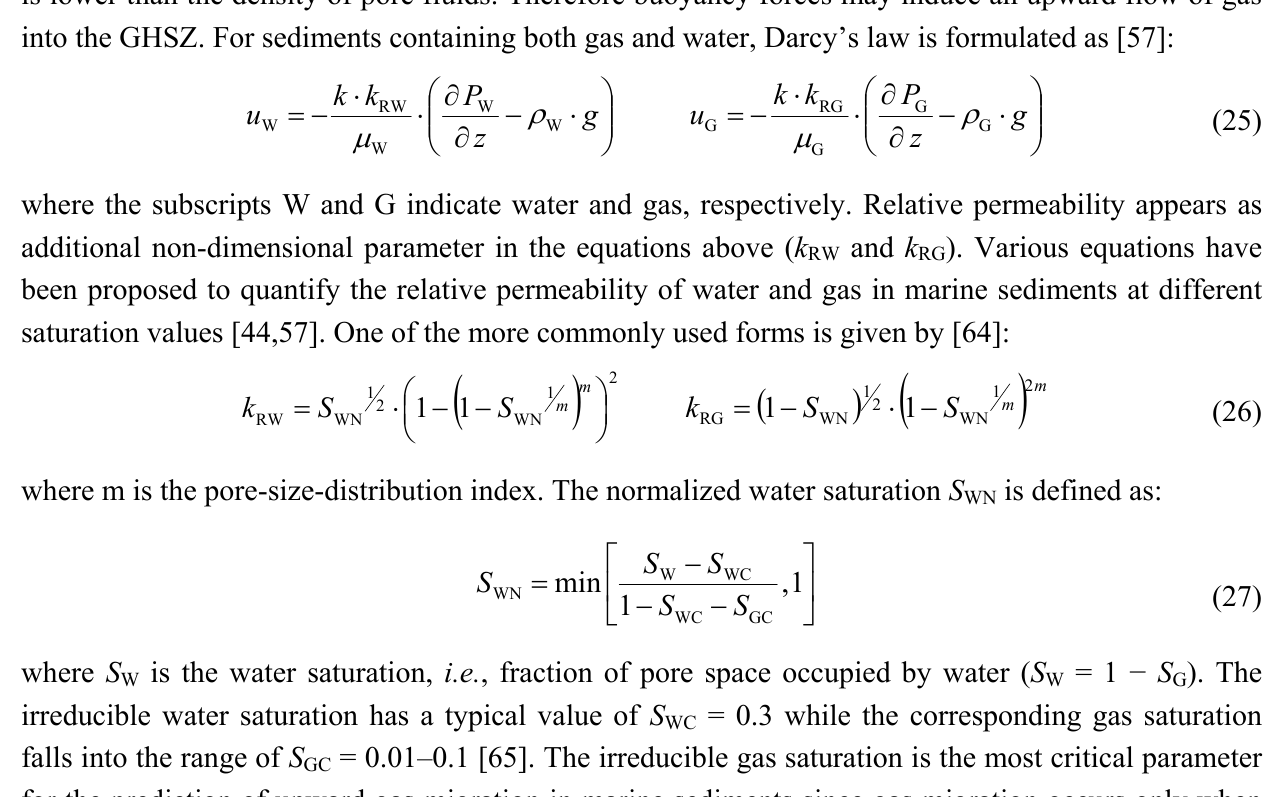
) in marine sediments as L